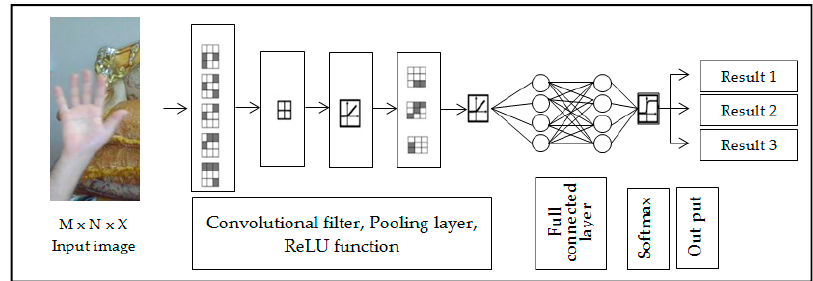
Figure 12. Simple example on deep learning convolutional neural network architecture.